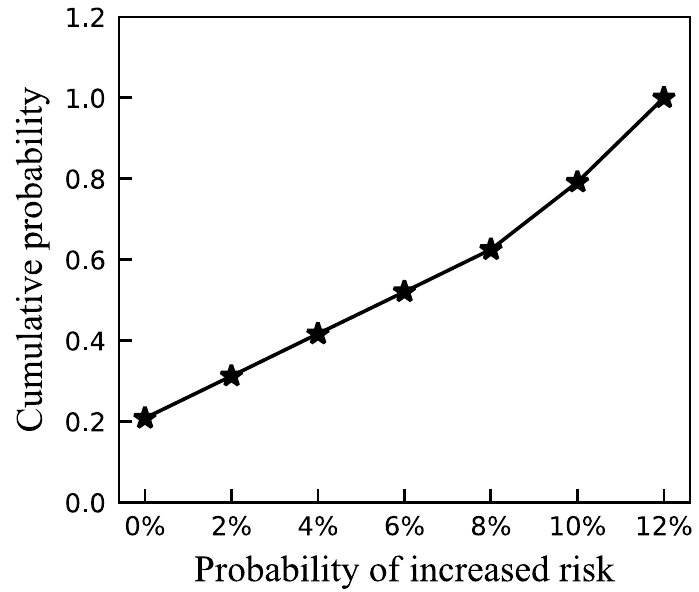
Figure 4. The cumulative probability of risk